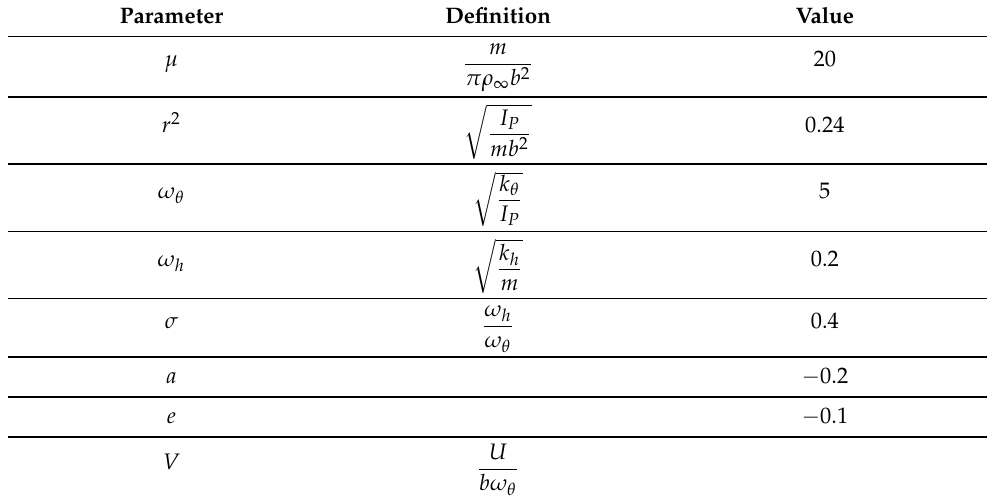
Table 1. Properties of the airfoil cross-section.